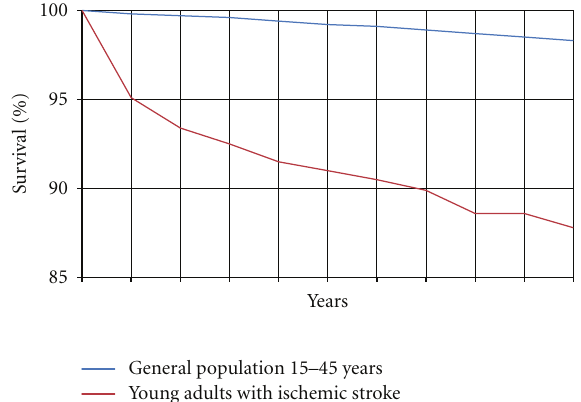
Figure 1: Graph showing a comparative approximation of the di ff erent probabilities of survival at 10 years in young adult patients (15–45 years) with ischemic stroke and the general population aged 15–45 years. (based on data of study of Varona et al.